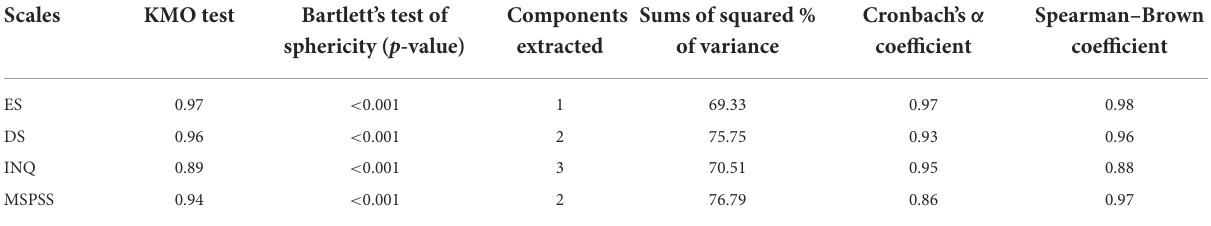
TABLE 3 Validity and reliability tests of the scales ( n =